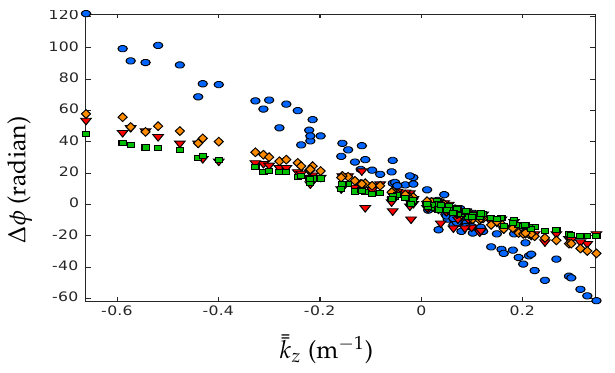
Figure 5. The unwrapped phase difference ∆ φ given the multi-pass interferometric factor ¯¯ k z . • Eiffel Tower, (cid:72) Cristal Tower, (cid:7) Keller Tower, (cid:4) Mirabeau Tower. Table 3. Reference height, height measured by linear regression over the temporal stack and coefficient of determination R 2 of the regression. Eiffel Tower Cristal Tower Keller Tower Mirabeau Tower h reference 177.1